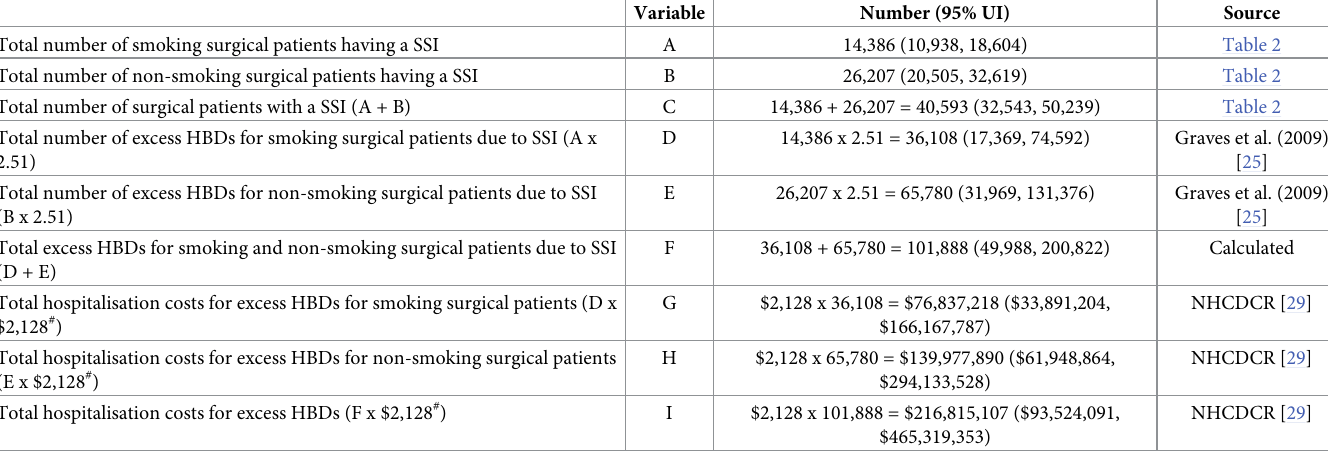
Table 3. Estimated annual expected number of surgical site infections, hospital bed-days and costs for smoking and non-smoking surgical patients in Australian public hospitals.